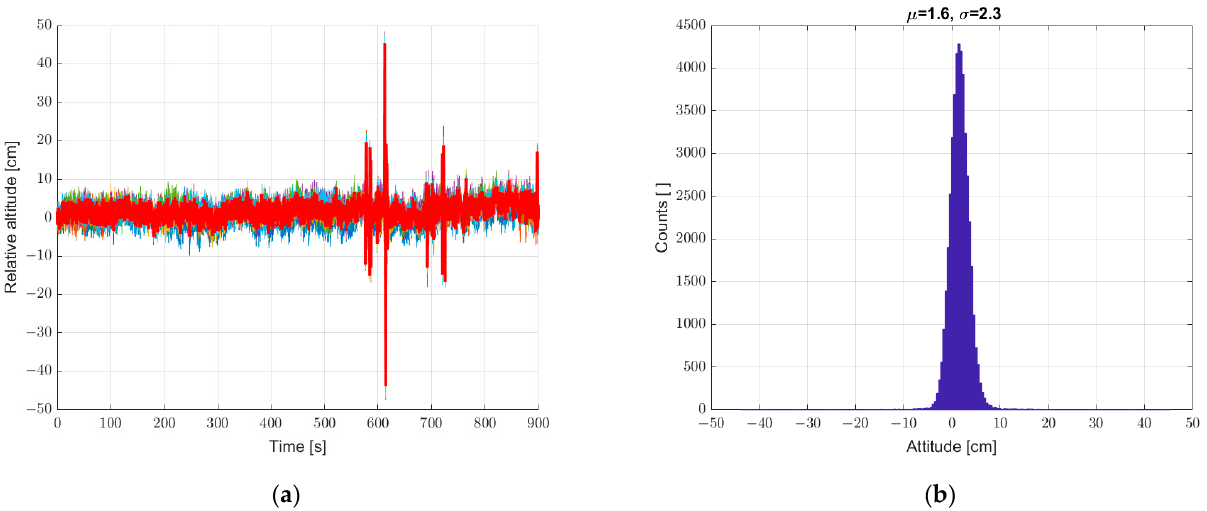
Figure 7. ( a ) Graph over time from six sensors with correction from reference sensor, and ( b ) histo- gram. Static measurements—sensor array at standstill.